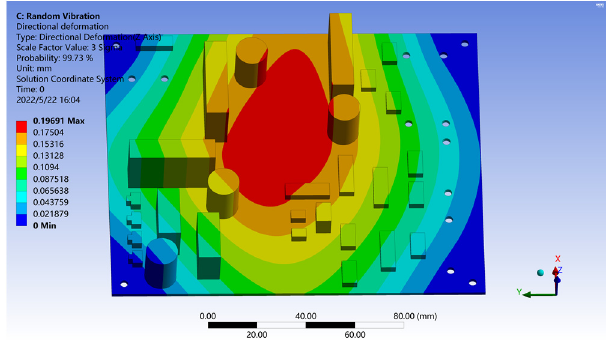
Figure 15. PCB deformation results after optimization.